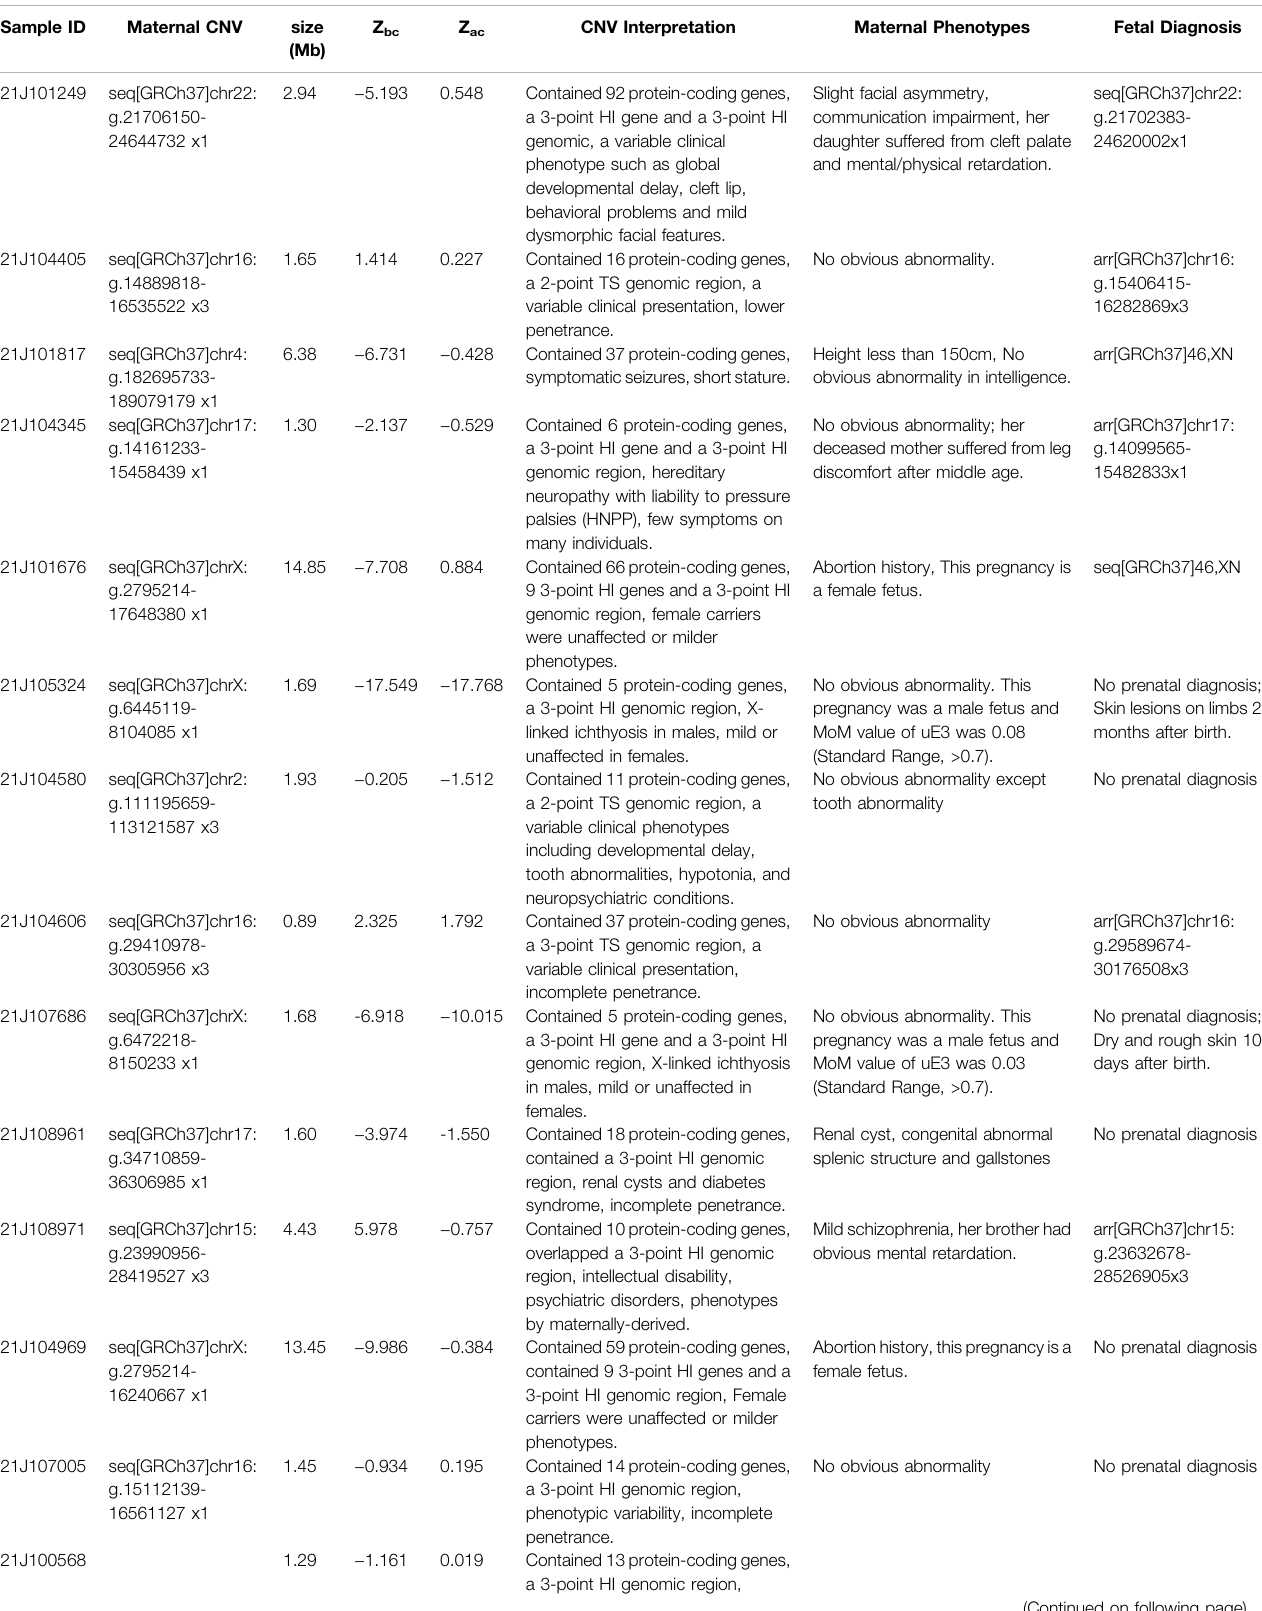
TABLE 2 | 17 Maternal CNVs Detected by NIPT and Fetal Diagnosis